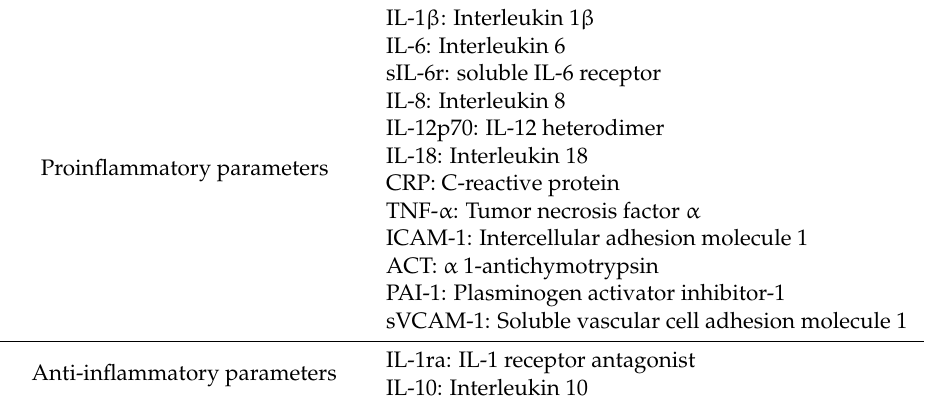
Table 2. Immunological markers and their role in inflammatory processes assessed in the articles